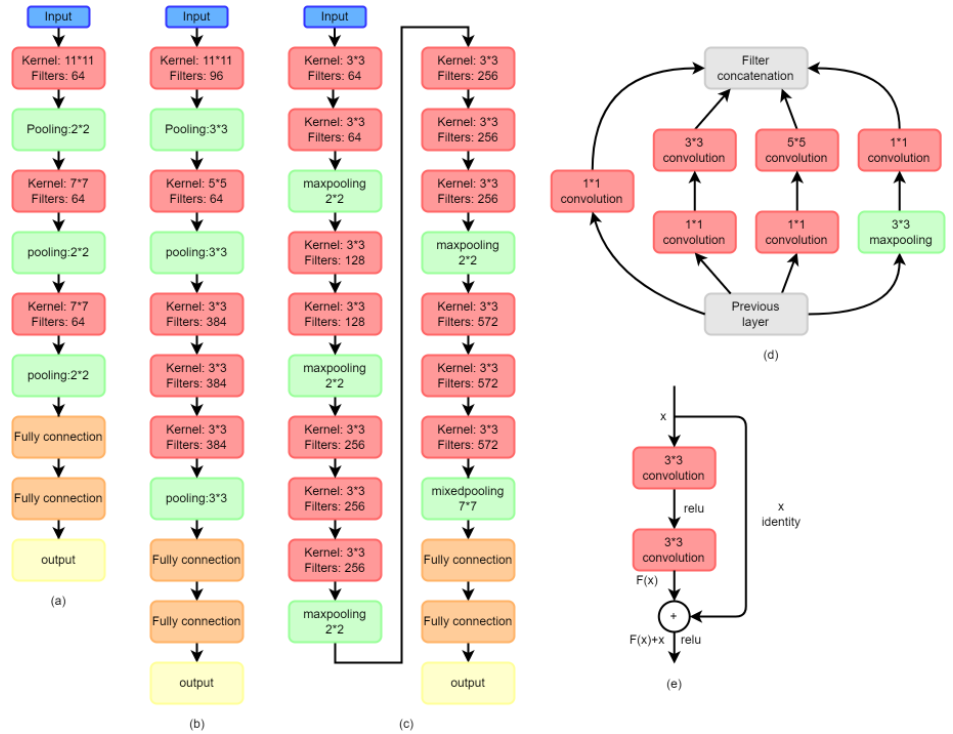
Figure 4. The structure of the convolutional neural network (CNN) methods: ( a ) LeNet5, ( b ) AlexNet, ( c ) VGGNet, ( d ) the inception structure in GoogleNet, and ( e ) the residual module in ResNet. Five M-CNN models are designed based on the above models: M-LeNet, M-AlexNet, M-GoogleNet, M-VGGNet, and Table 1. The architecture of M-LeNet5.